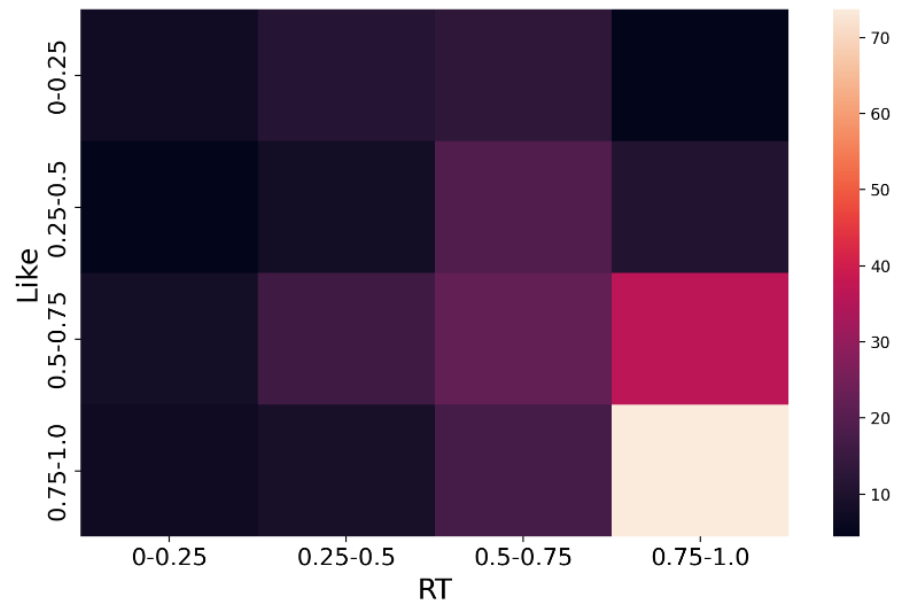
Figure 5. Relationship between RT, like, and emotion vectors (8 emotions).